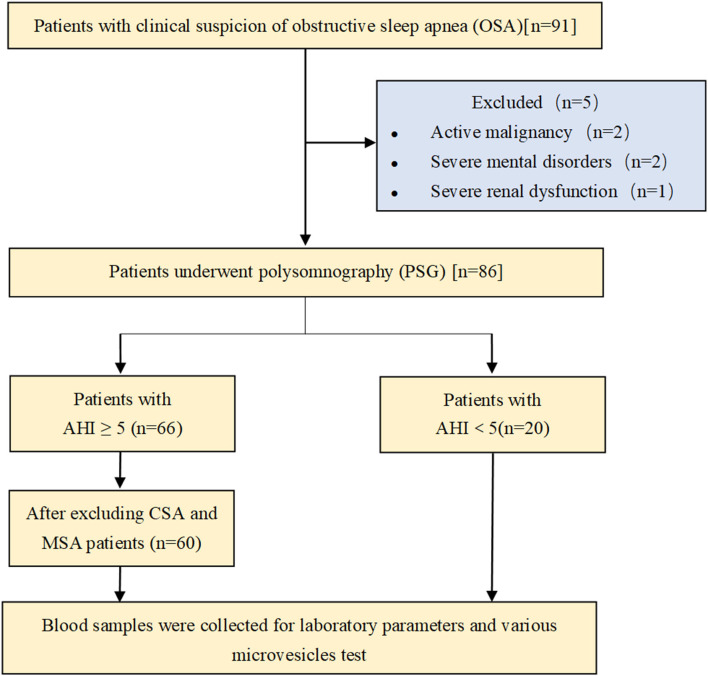
Schematic flowchart for the selection of studies.